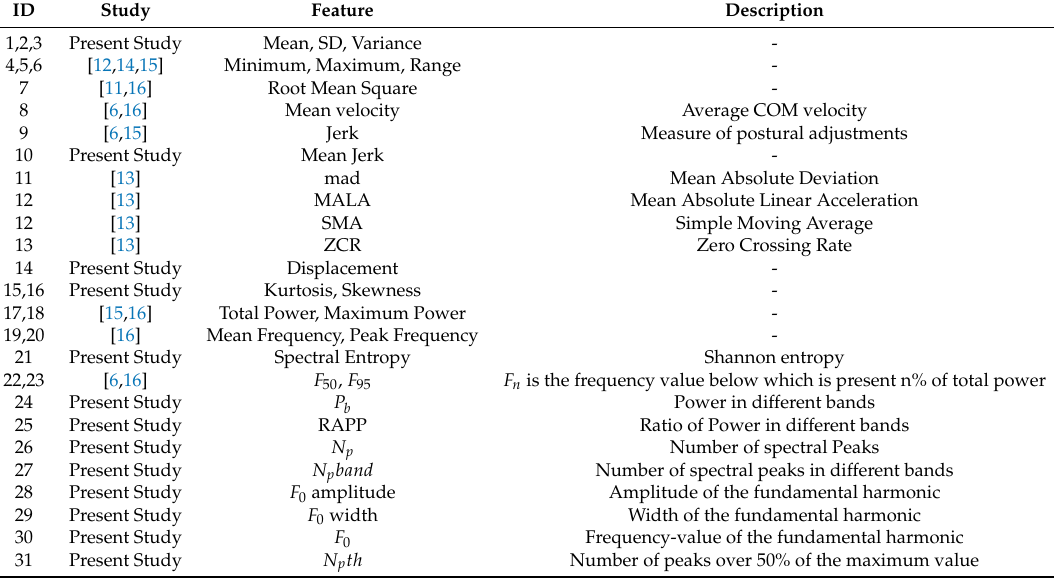
Table 4. Dataset of features extracted from the each component of acceleration and angular velocity